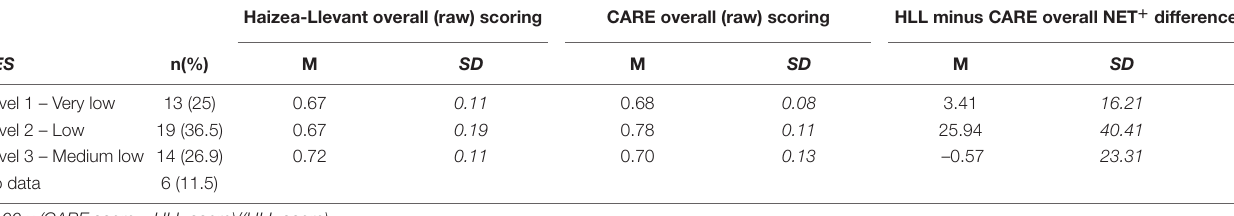
TABLE 2 | Raw and net percentage change index (NET) for overall scoring differences between Haizea-Llevant (HLL) and CARE. Haizea-Llevant overall (raw) scoring CARE overall (raw) scoring